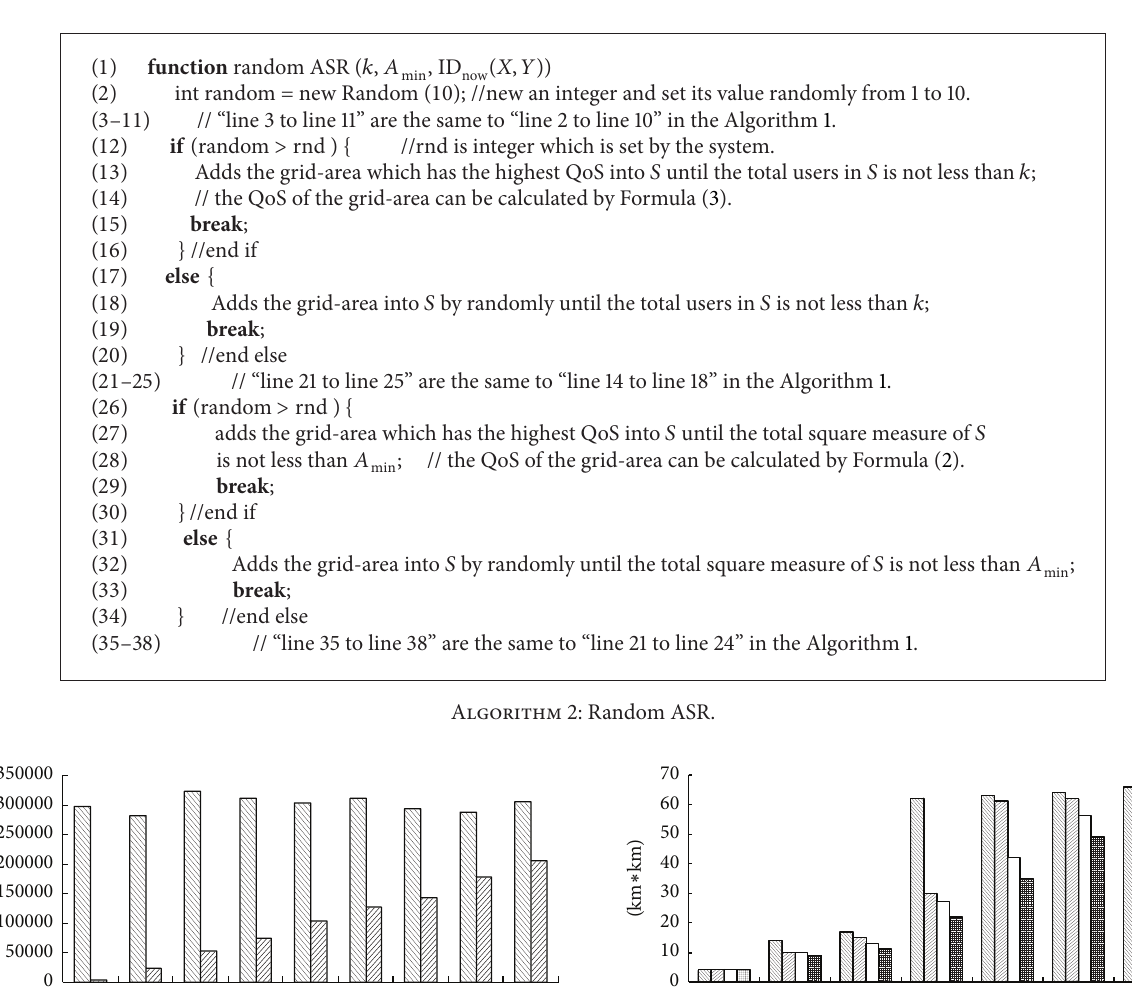
k Our random algorithm Our optimal algorithm